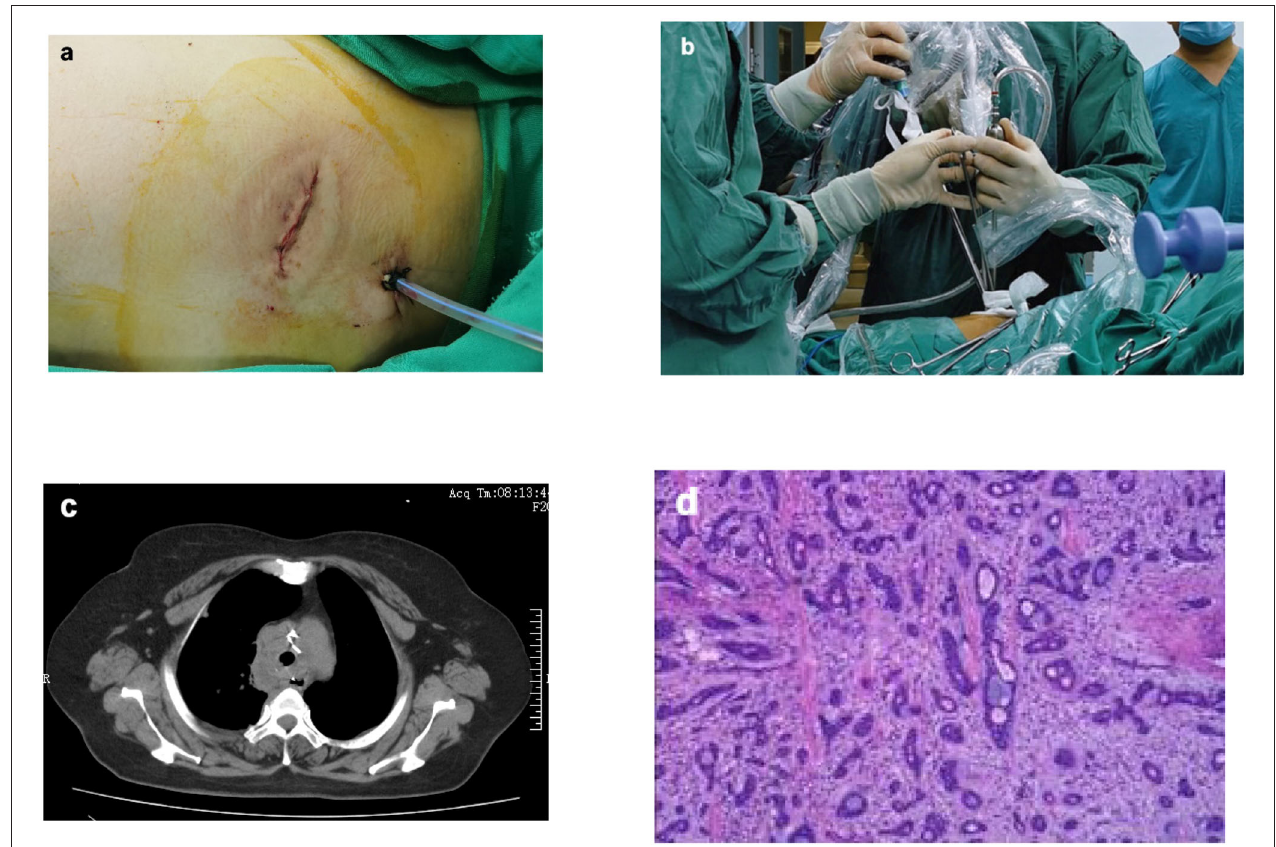
FIGURE 3 | Surgical photos and postoperative examination of the patient. The surgical incision was ∼ 4cm (a) ; The endoscope and surgical instruments were introduced via the same incision (b) ; Postoperative CT revealed that the trachea was patent (c) ; Postoperative pathologica results revealed adenoid cystic carcinoma (ACC) (d)